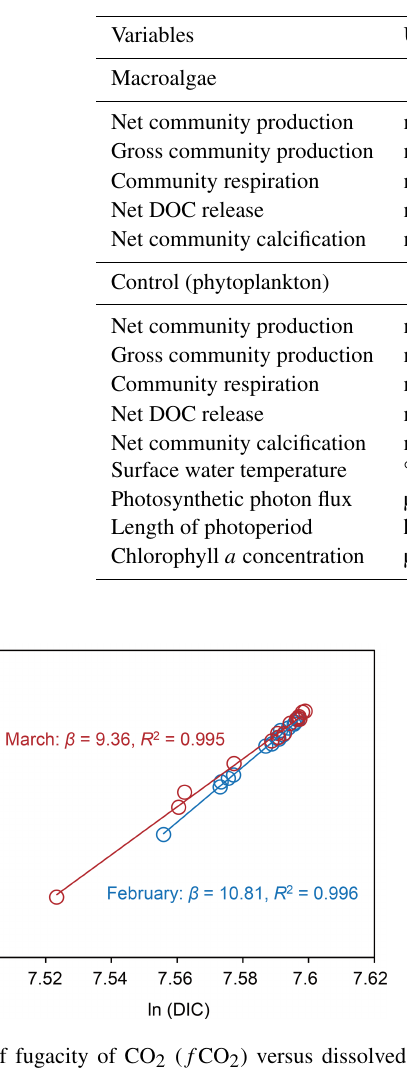
Figure 4. Plots of fugacity of CO 2 ( f CO 2 ) versus dissolved in- organic carbon (DIC) and regression lines used to determine the homogeneous buffer factors ( β ) as